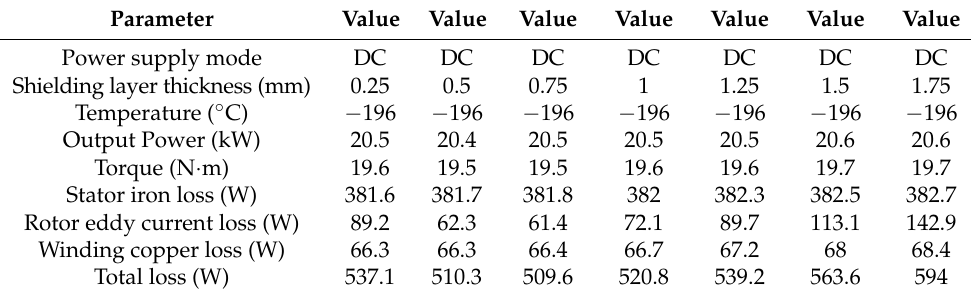
Table 6. Motor-loss data with different shielding-layer thicknesses at − 196 ◦ C. Parameter Value Value Power supply